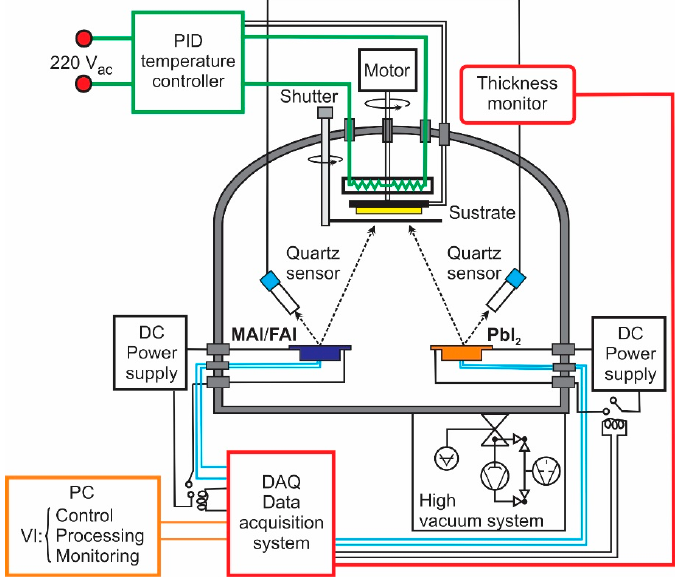
Figure 1. Scheme of the system used to grow CH 3 NH 3 PbI 3 (MAPI) or (NH 2 ) 2 CHPbI 3 (FAPI) films by sequential evaporation of precursors. PID: proportional integral derivative control algorithm.